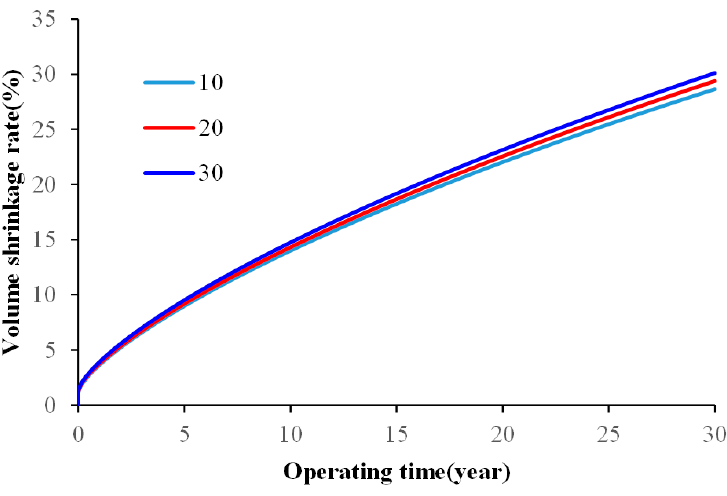
Figure 17. Volume shrinkage rate of three caverns with different well spacings.